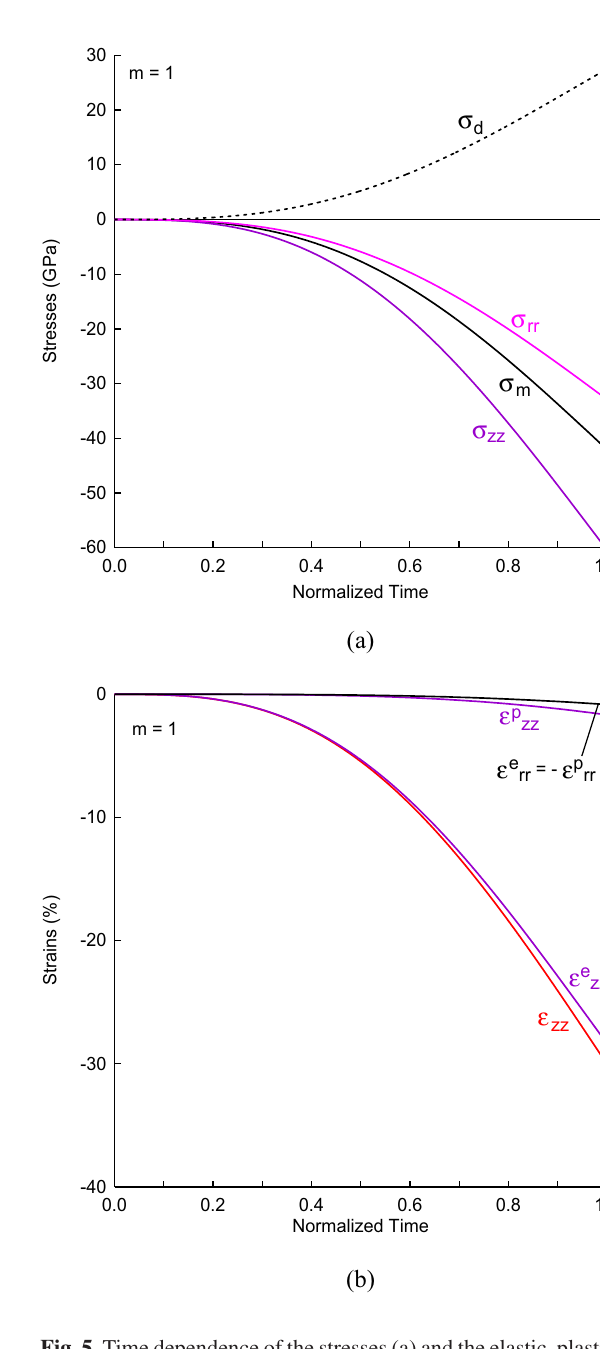
Fig. 5. Time dependence of the stresses (a) and the elastic, plastic, and total strains (b) of a linear (m = 1) elastic-viscoplastic